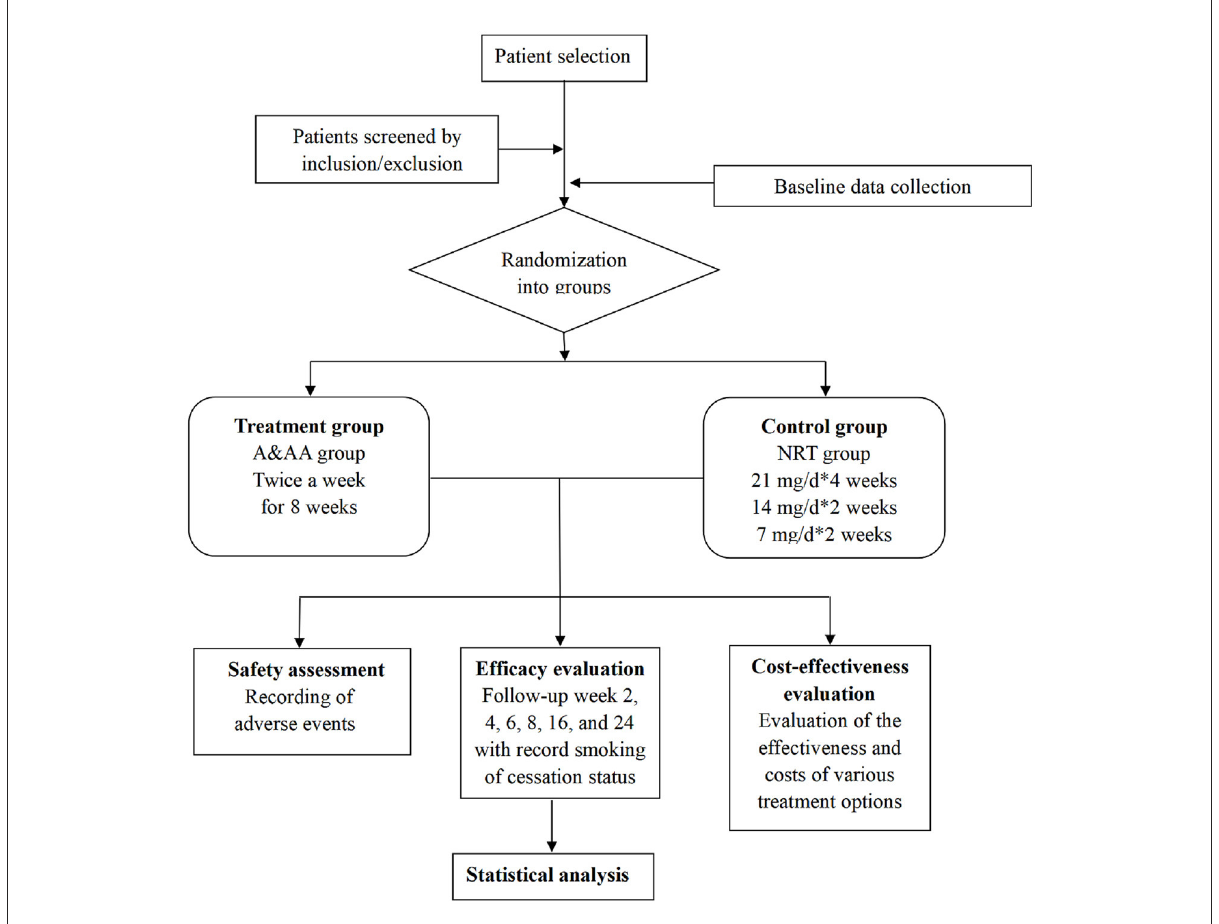
FIGURE1 Patient selection and methodological